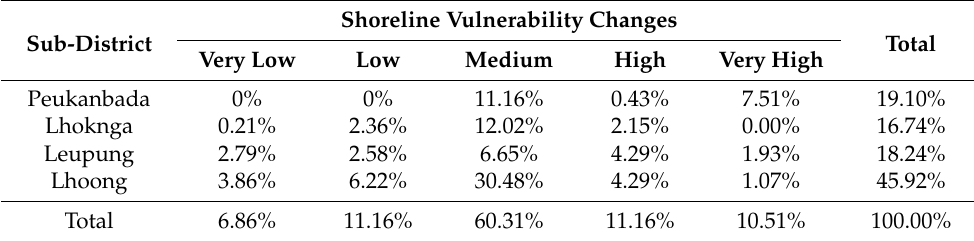
Figure 7. The level of coastal vulnerability due to changes in coastlines in the last five years (2015–2019). Table 7. Percentage of coastal vulnerability in terms of coastline